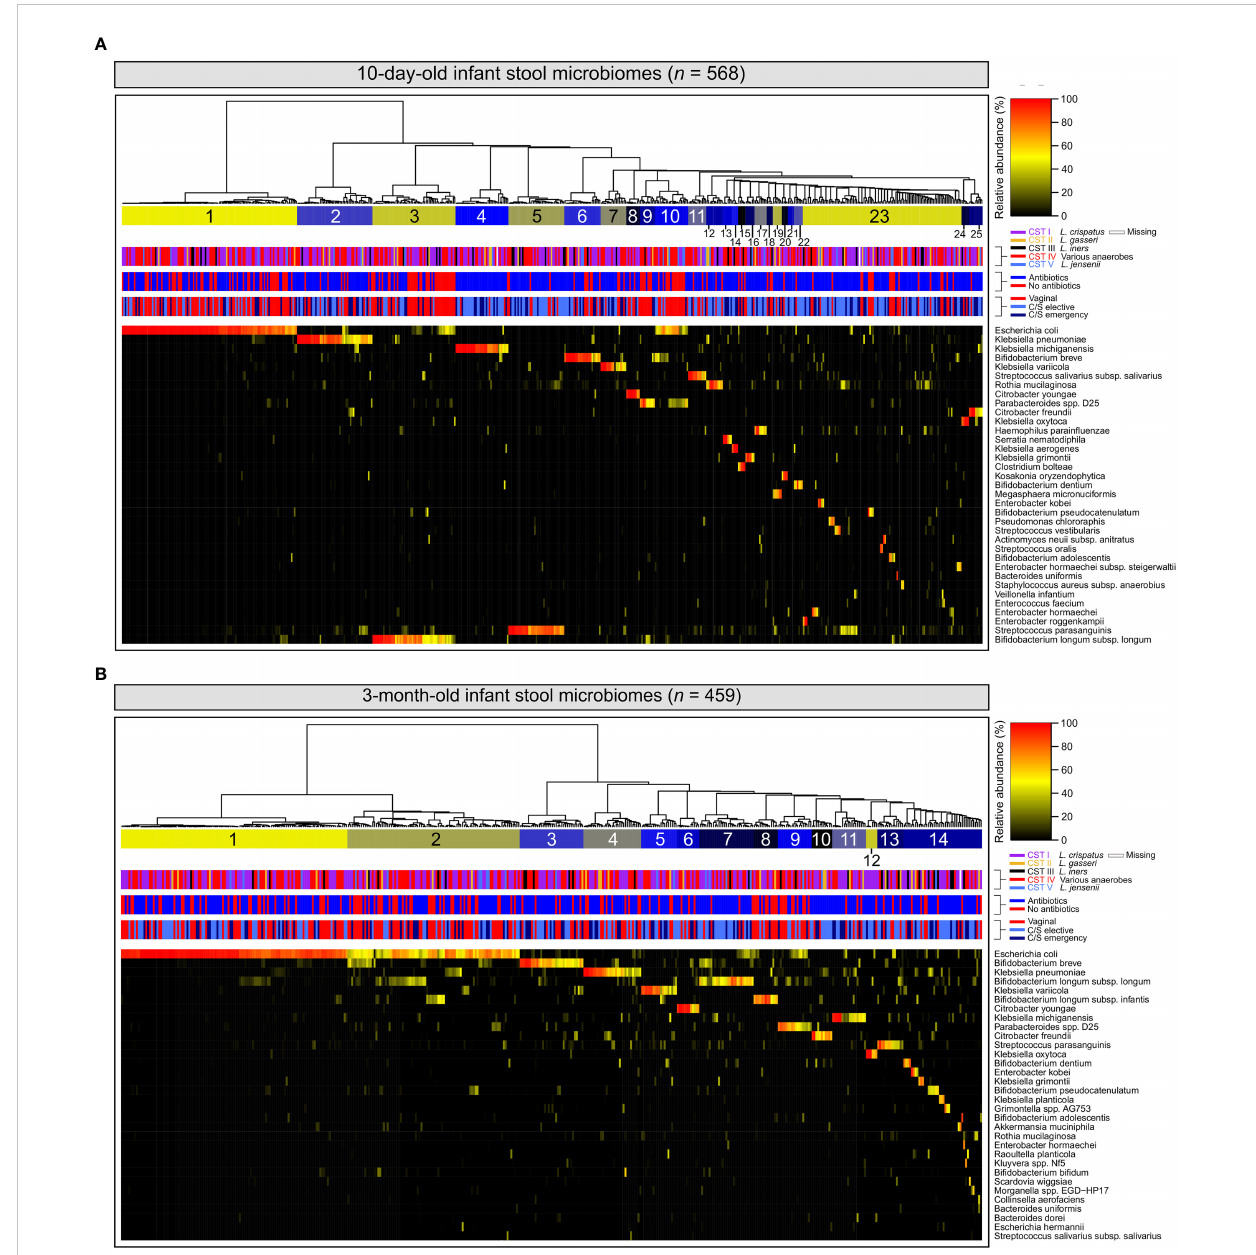
FIGURE 1 Infant stool microbiomes exhibit low diversity and are typically dominated by a single species: Hierarchical clustering of cpn 60 stool microbiomes constructed from Euclidean distance matrices of proportional abundance data from 10-day (A) and 3-month (B) -old infants. The 35 most prevalent taxa are shown. From top to bottom, colour bars represent: infant stool microbiome clusters de fi ned by nbClust, maternal vaginal community state type, intrapartum antibiotic exposure, and delivery